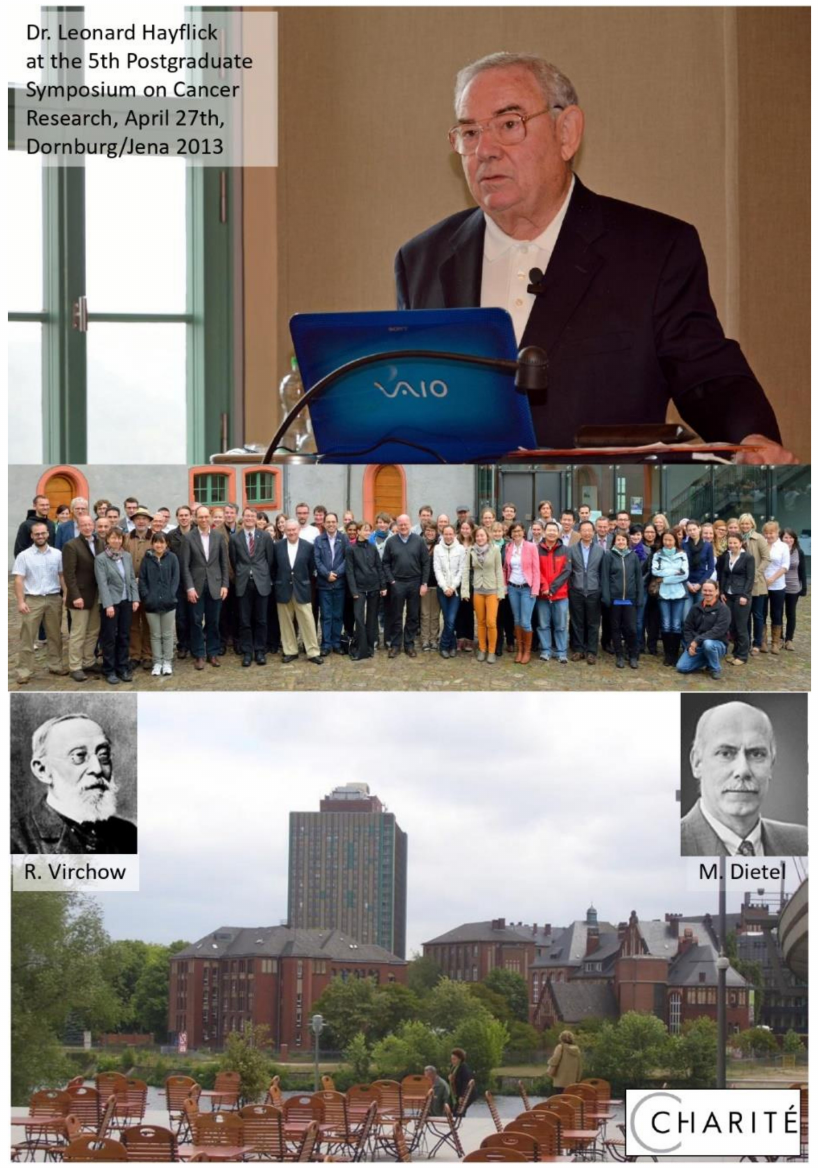
Figure 4. This article is dedicated to Dr. Leonard Hayflick, shown here during his lecture at the 5th postgraduate cancer research symposium in the old castle of Dornburg, which is located close to